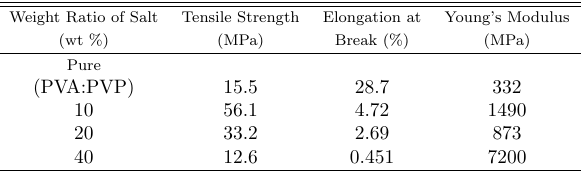
Table 1: Tensile property values of pure and PVA:PVP polymer blend films reinforced with different weight ra- tios of CdCl 2 · H 2 O